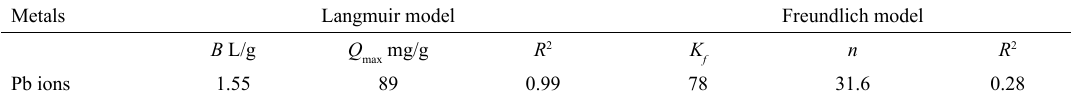
Table 2. Parameter values calculated using the pseudo-first and the pseudo-second order models for the adsorption of Pb(II) onto HA.